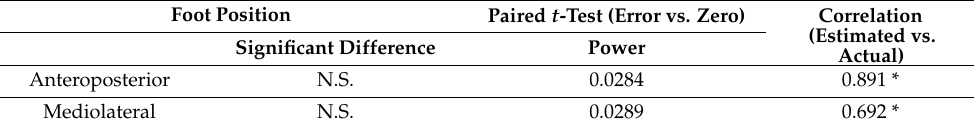
Table 9. Statistical results.